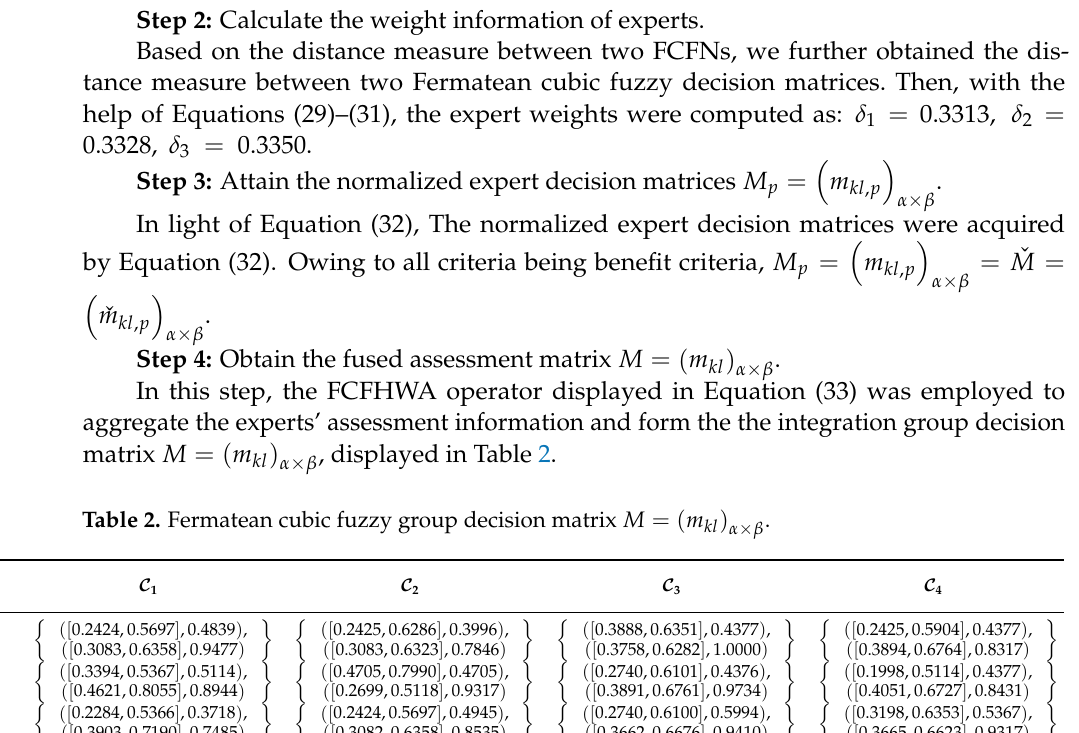
Table 2. Fermatean cubic fuzzy group decision matrix M = ( m kl )